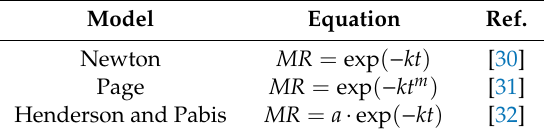
Table 3. Kinetic models reported in various literature for drying